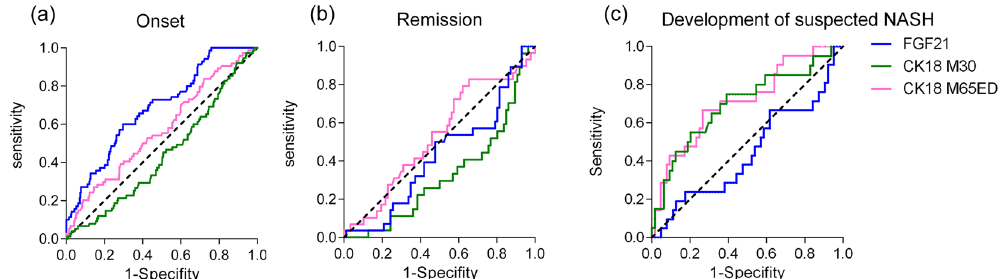
Figure 2. ROC curves for predicting the development and progression of NAFLD. ( a ) ROC curves of FGF21, M30 and M65ED for predicting the onset of simple steatosis. ( b ) ROC curves for predicting the remission of NAFLD during follow-up. ( c ) ROC curves for predicting suspected NASH in subjects who sustained